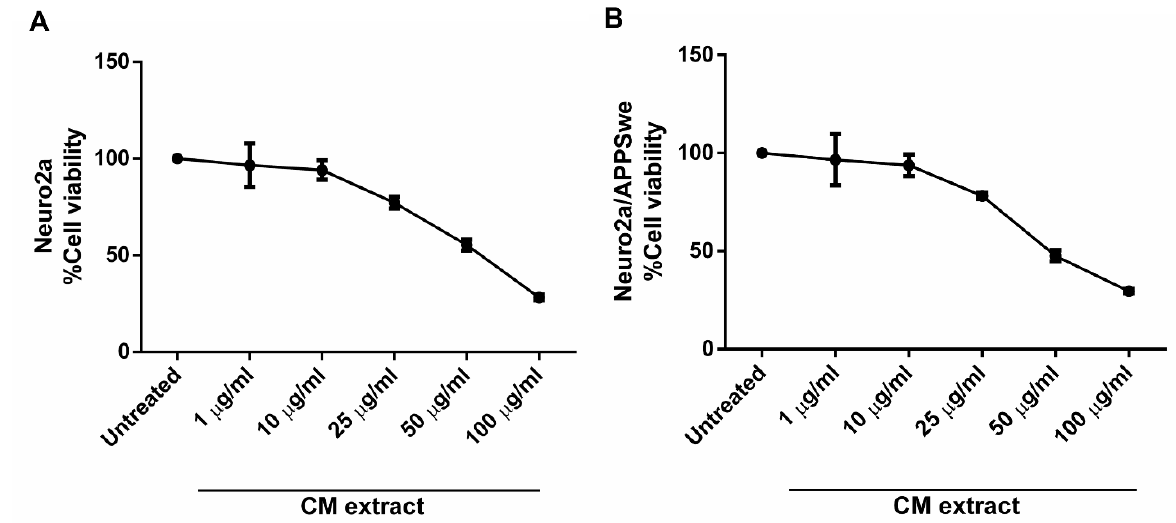
Figure 2. MTT assay. Cell viability of ( A ) Neuro2a and ( B ) Neuro2a/APPSwe cells after treatment with the various concentrations of CM extract for 48 h. The extract concentration of 10 µg/mL with more than 90% cell survival was chosen as the test concentration for subsequent experiments.